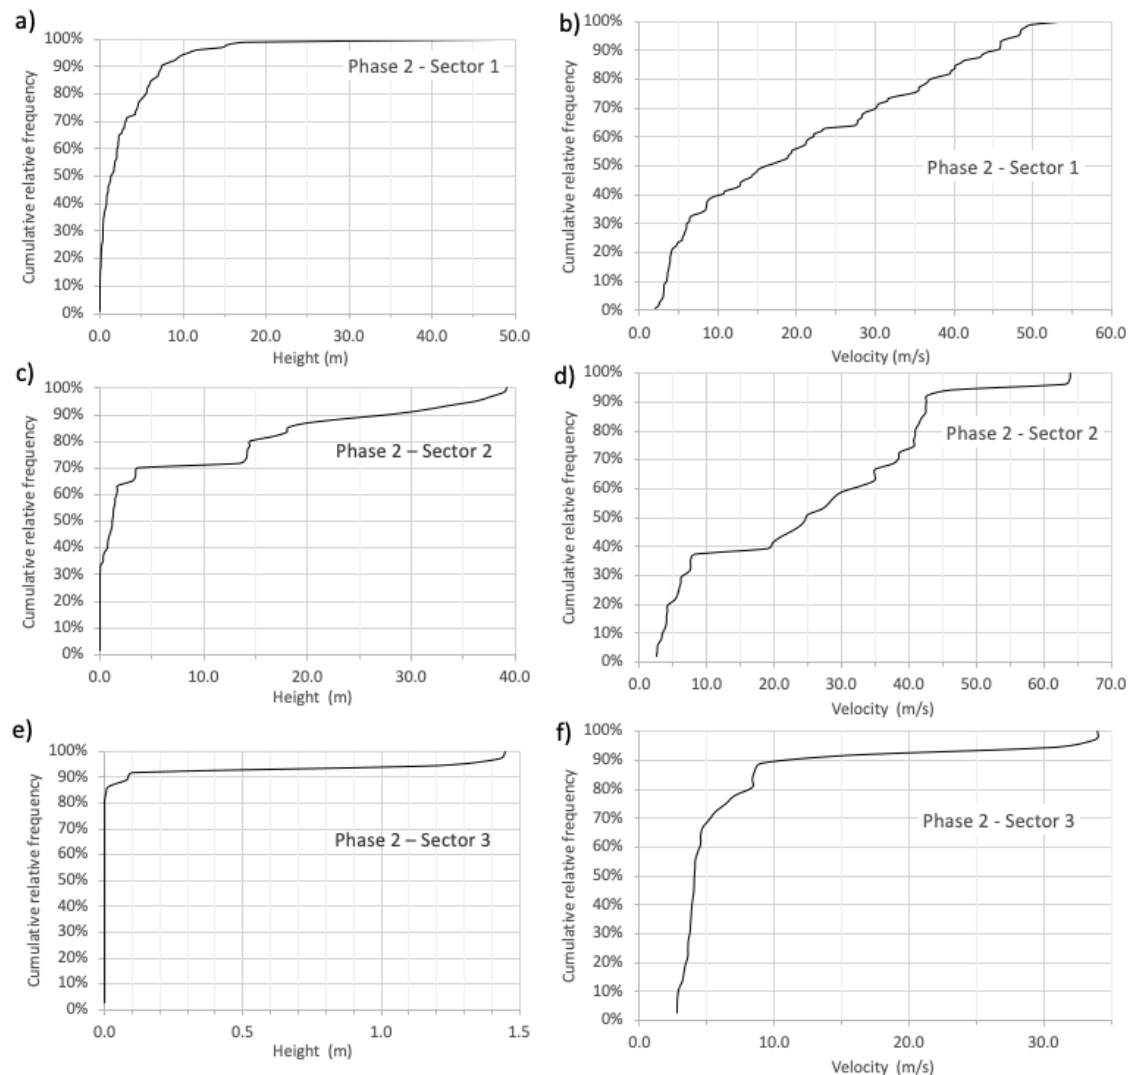
Figure 11. Cumulative relative frequency of heights ( left ) and velocities ( right ) for Phase 2 trajectories reaching Sector 1 ( a,b ), Sector 2 ( c,d ) and Sector 3 ( e,f ).